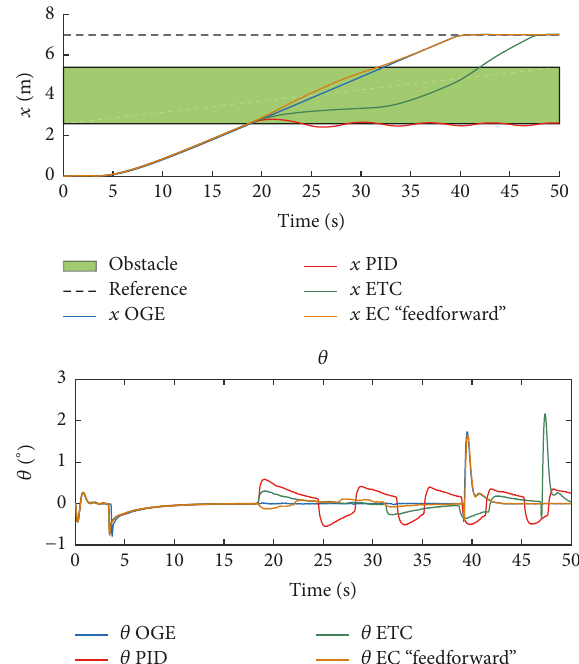
Figure 23: Flying over obstacle: comparison of controllers.